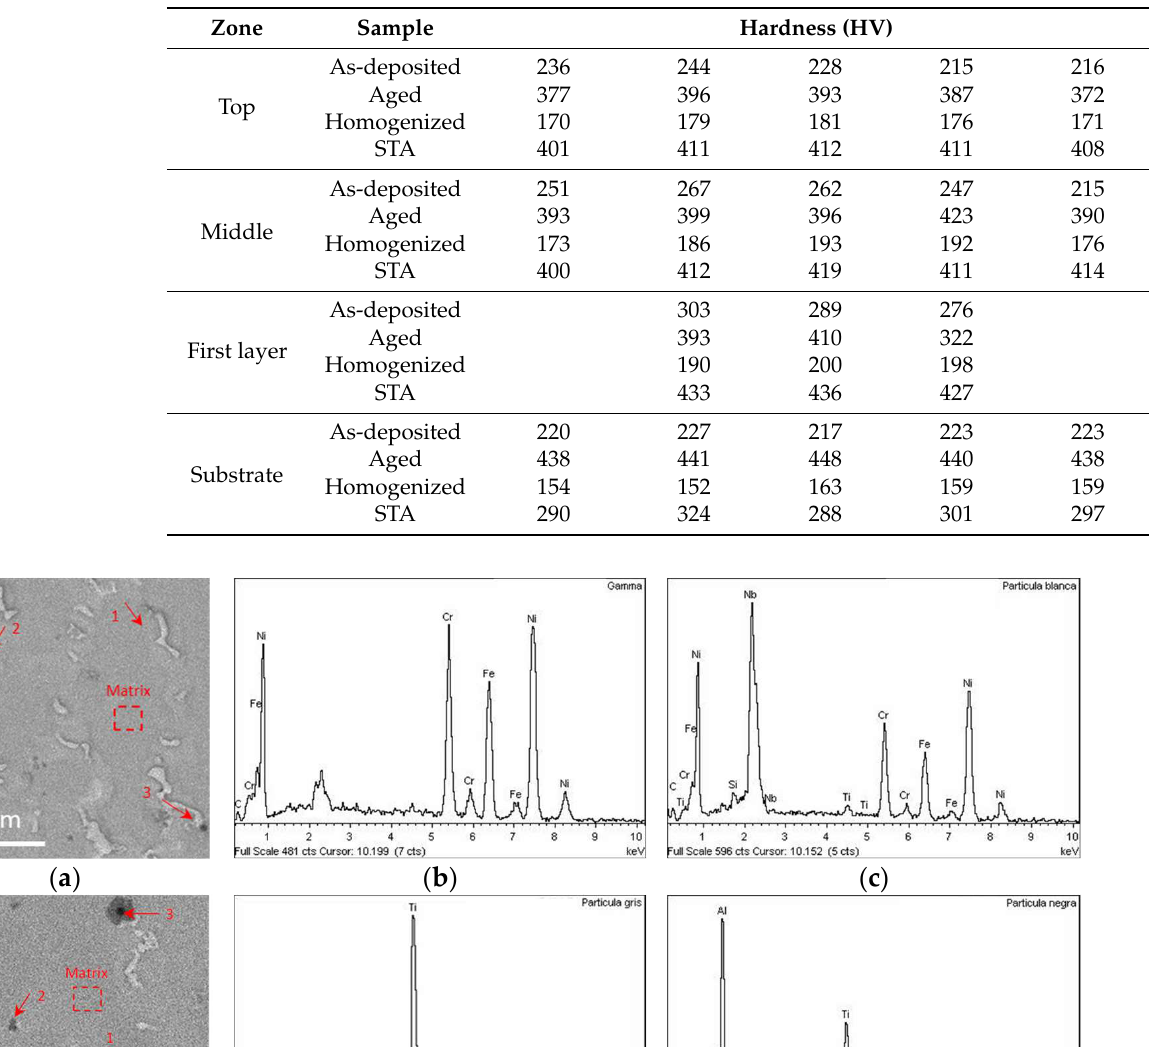
Table 5. HV hardness in top, middle, first layer, and substrate of all samples.